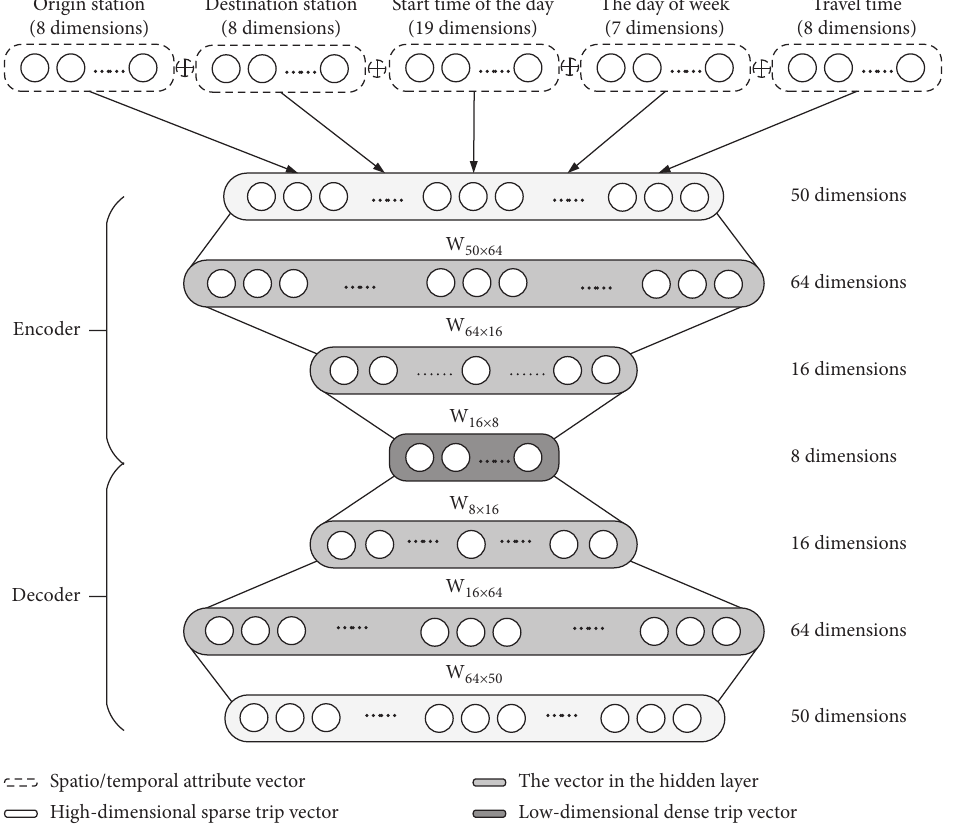
Figure 3: Embedding spatiotemporal semantics using